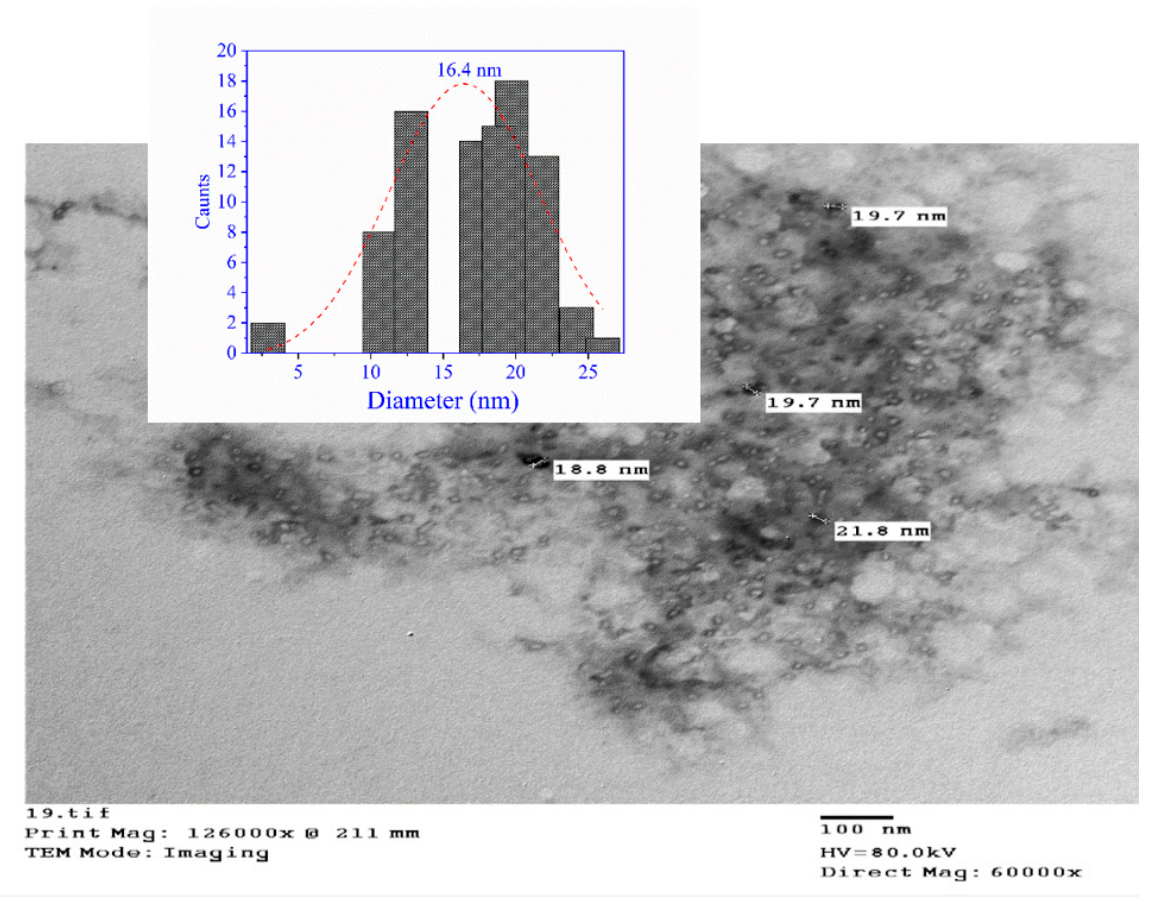
Figure 1. Micrograph of the chitosan nanoparticles.